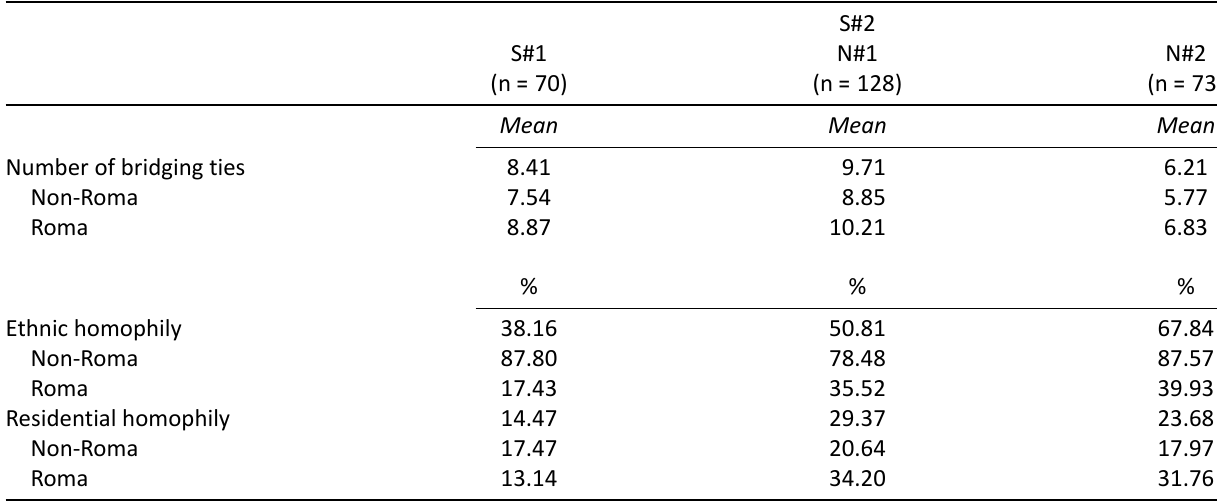
Table 4. Network characteristics of bridging ties.